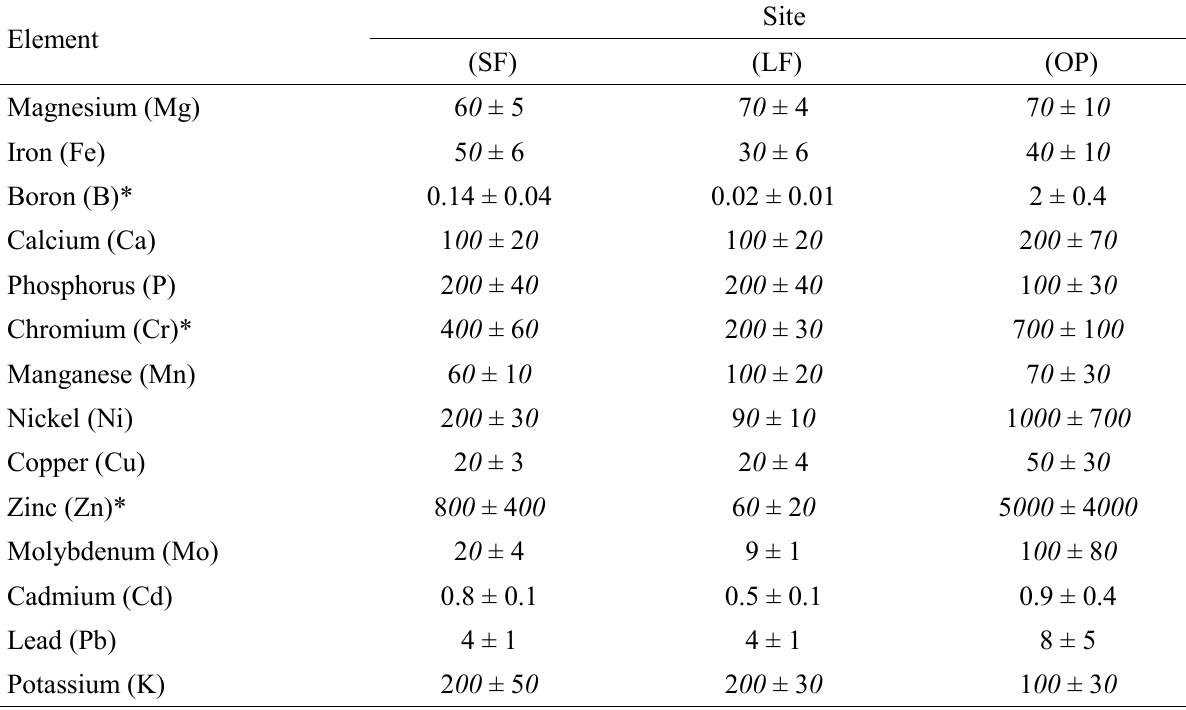
Table 2. Element concentrations (mg/kg) in the three Alan Bunga peat swamp forest ecosystems. The values are means ± standard error of mean (SEM). ‘ 0 ’ digits in italics are not significant but indicate the position of the decimal point. Asterisks indicate variables that were shown to differ significantly ( n = 3; P < 0.05) between the three peat ecosystems using the non-parametric Kruskal-Wallis